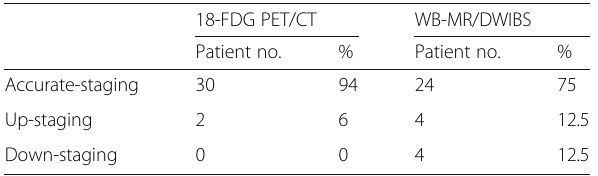
Table 2 Correlation between WR-MR/DWIBS and the reference